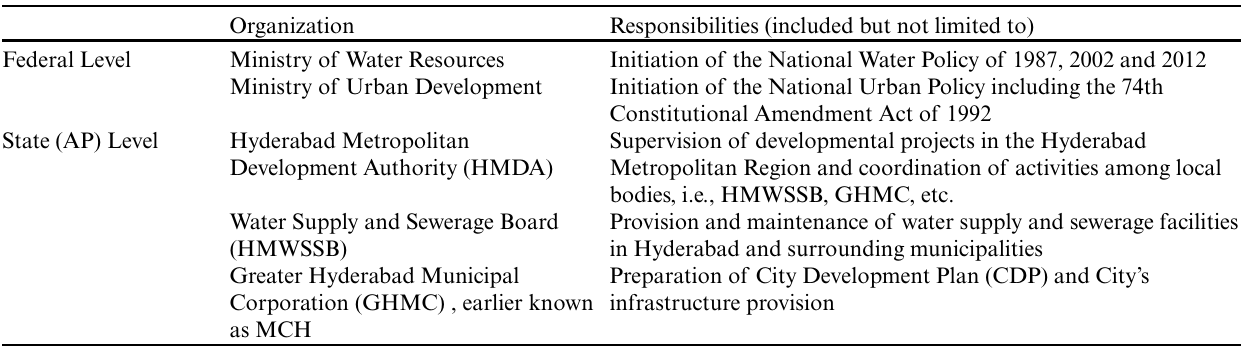
Table 1 . Regime actors at different administrative and political levels in relation to urban water governance in Hyderabad, Andhra Pradesh, India. Sources: Greater Hyderabad Municipal Corporation 2006, Hyderabad Metropolitan Development Authority 2010, Ministry of Urban Development 2012, Ministry of Water Resources 2012 a .